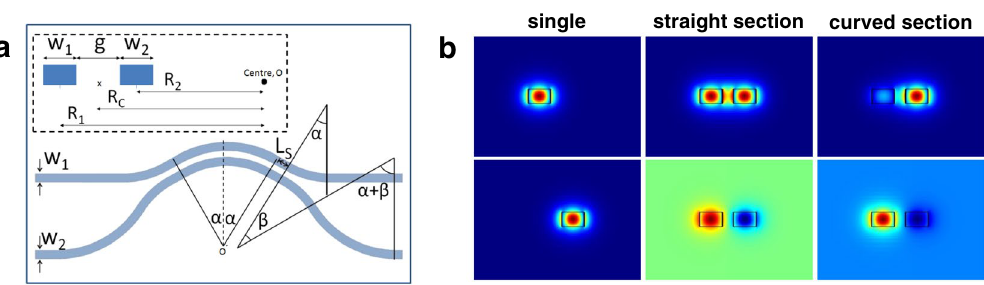
Figure 1. ( a ) SOI curved directional coupler layout and design parameters. ( b ) First and second TE modes at various points along the curved directional